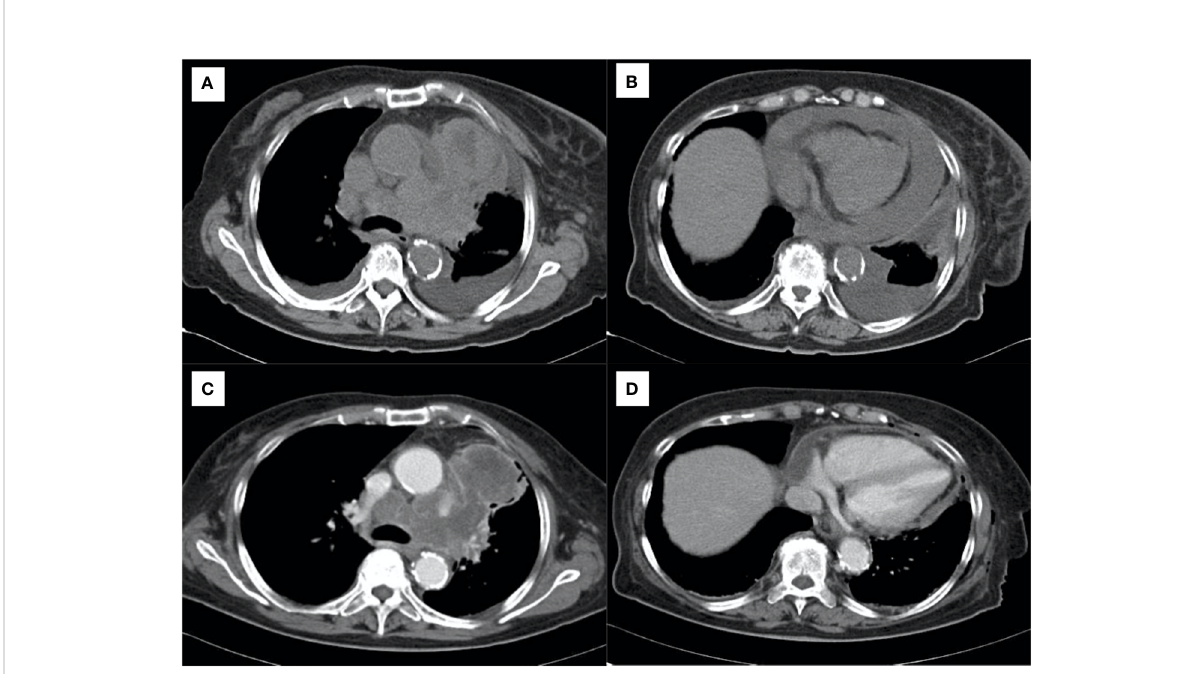
FIGURE 1 Chest computed tomography showing (A) primary lung cancer and bilateral pleural effusions and (B) pericardial effusion. (C, D) After drainage of the effusions and pleurodesis, showing control of the effusions before starting systemic